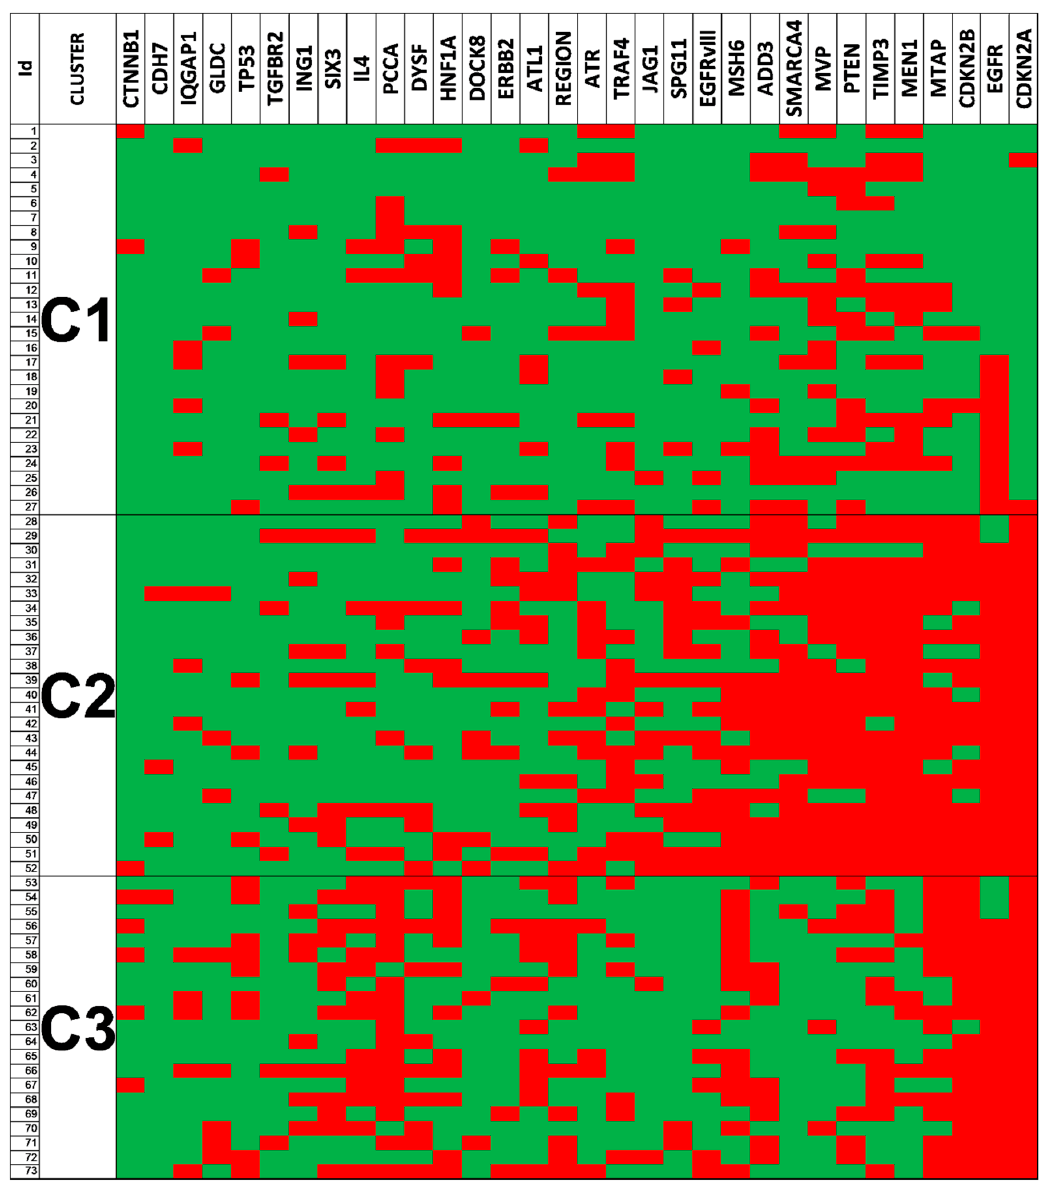
Figure 3. Clustering analysis. Heatmap from the hierarchical cluster classification. The patients included are represented on the Y-axis and the genes that contributed to the model on the X. Green squares show no SCNA, red squares show SCNA. C1, C2 and C3 are shown separately, and the distribution of SCNAs among offers a landscape where C1 is the one with less genetic alterations while C2 is the most affected one.